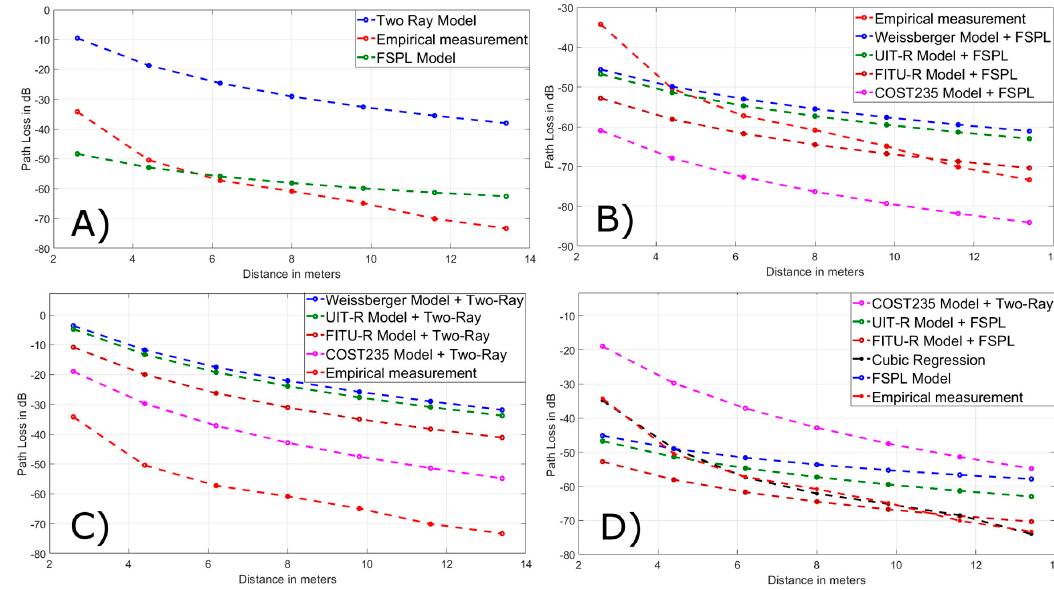
Figure 7. Field measurement at 1.5 m of soil vs. ( A ) models with LOS ( B ), empirical models + FSPL ( C ), empirical models + two-ray, ( D ) optimized model (cubic regression) and the others closest in values.